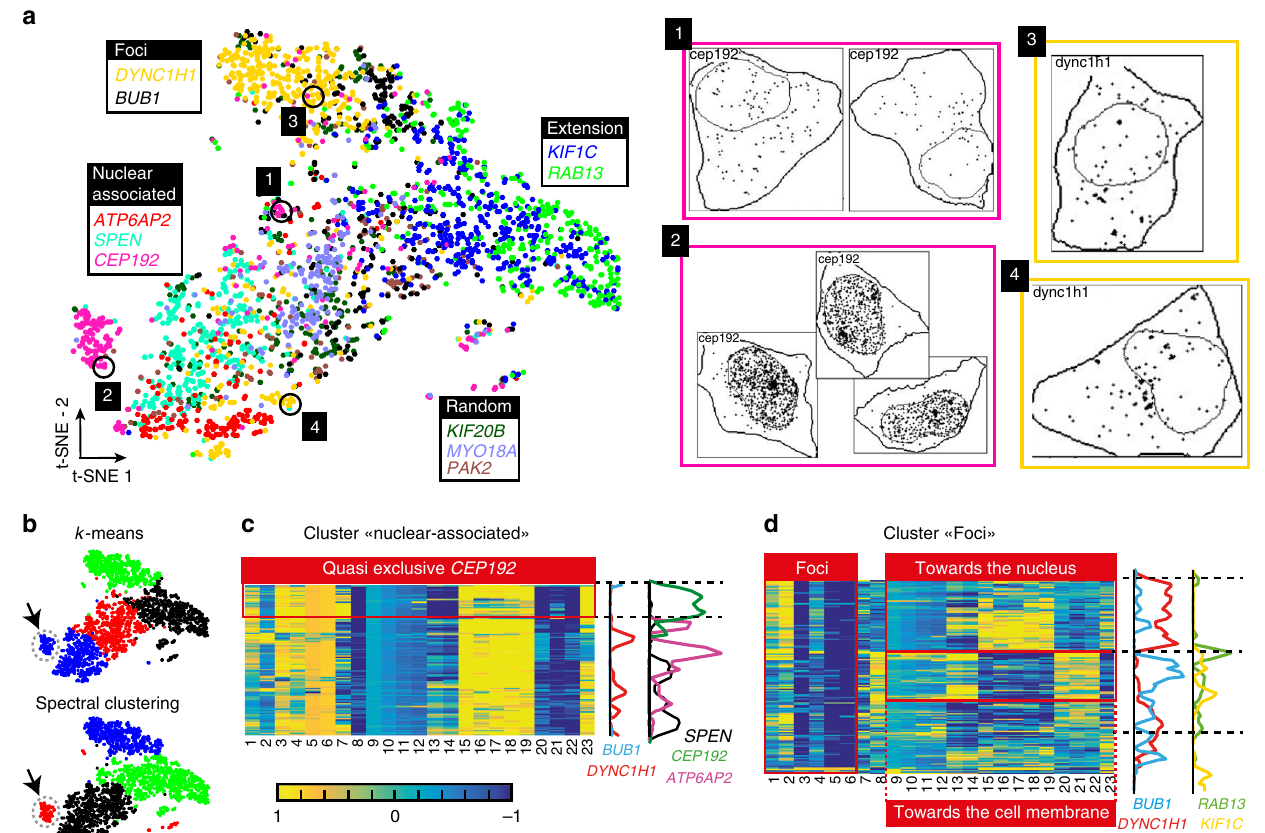
Fig. 3 Analysis of experimental data with unsupervised approaches. a t-SNE projection of the 23 localization features for smFISH experiments against 10 different genes. Each dot is one cell and is color-coded according to the gene. Images on the right are examples of DYNC1H1 and CEP192 cells with different localization patterns from the numbered regions in the t-SNE indicated with circles. b t-SNE plot as in a , but color-coded according to results of a k-means classi fi cation or spectral clustering. The latter fi nds a small cluster with strong intranuclear localization (lower plot, black arrow). c, d Examples of hierarchical clustering results. Each row is a cell, each column a localization feature (see list of features in Table 1). Plots on the right show the smoothed distribution of the most enriched genes in the